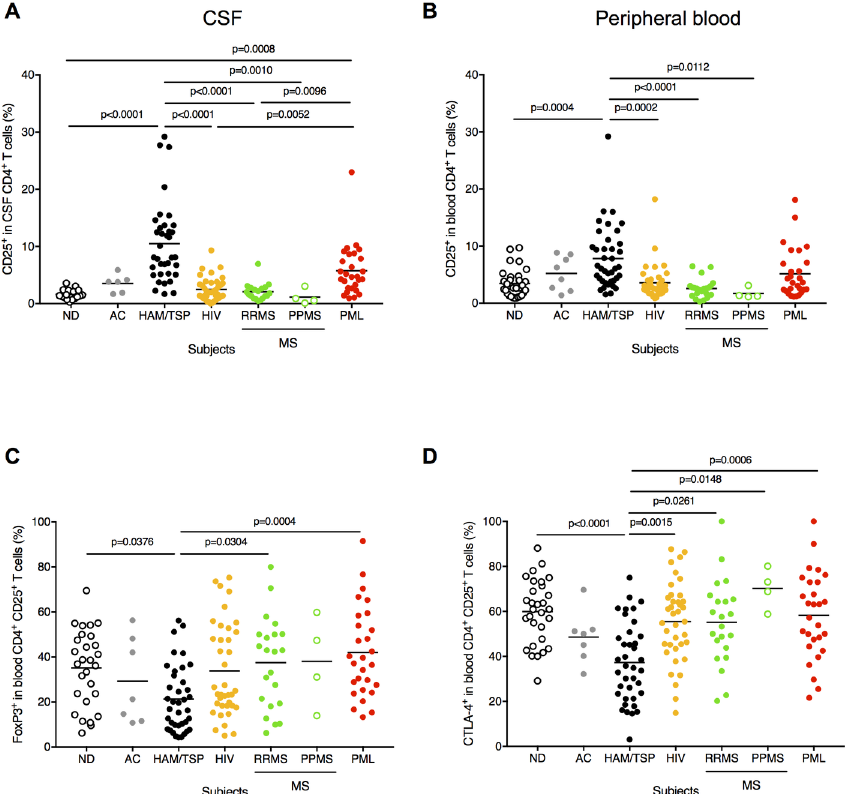
Fig 4. Detection of CD4 + CD25 + T cells in CSF of chronic virus infection and/or neuroinflammatory diseases. (A) Comparison of frequency of CD4 + CD25 + T cells in CSF using Kruskal-Wallis test with Dunn’s test. The horizontal line represents the mean. (B) Comparison of frequency of CD4 + CD25 + T cells in peripheral blood using Kruskal-Wallis test with Dunn’s test. The horizontal line represents the mean. (C) Comparison of frequency of FoxP3 in peripheral blood CD4 + CD25 + T cells using Kruskal-Wallis test with Dunn’s test. The horizontal line represents the mean. (D) Comparison of frequency of CTLA-4 in peripheral blood CD4 + CD25 + T cells using Kruskal-Wallis test with Dunn’s test. The horizontal line represents the